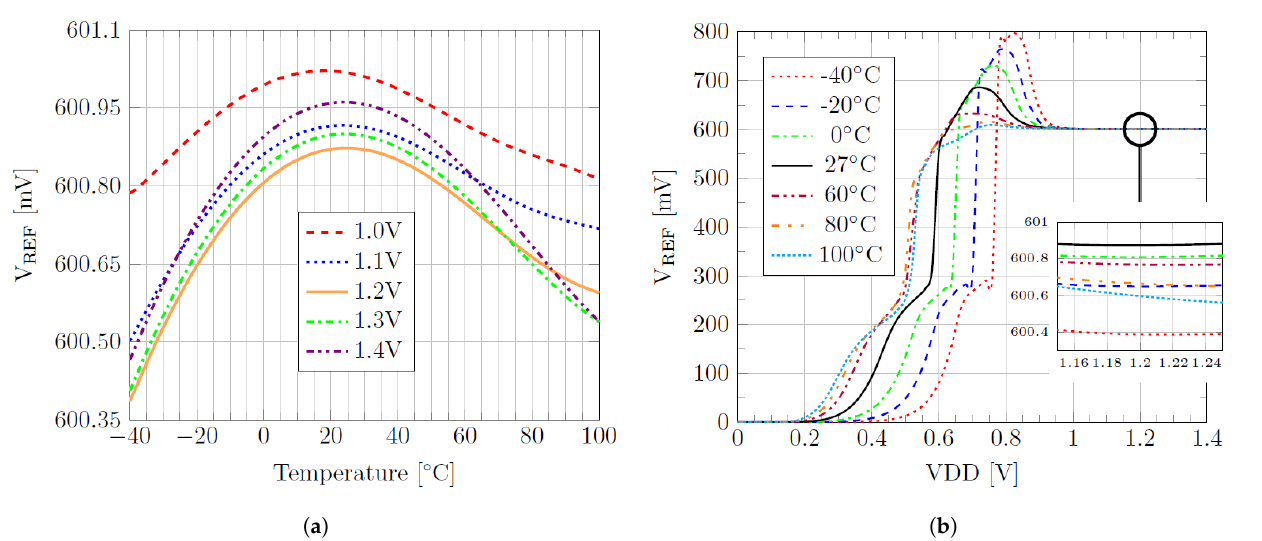
Figure 10. Post-layout simulation of ( a ) V REF versus temperature at different VDD and ( b ) V REF versus VDD at different temperatures.